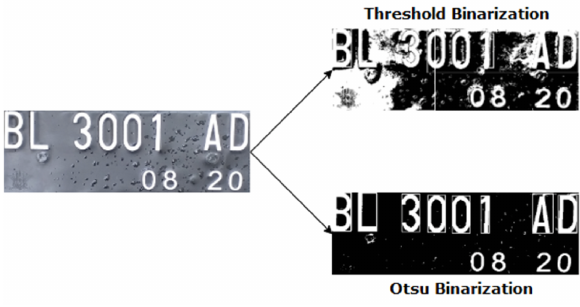
Fig. 9. Comparison of the threshold and Otsu binarization methods